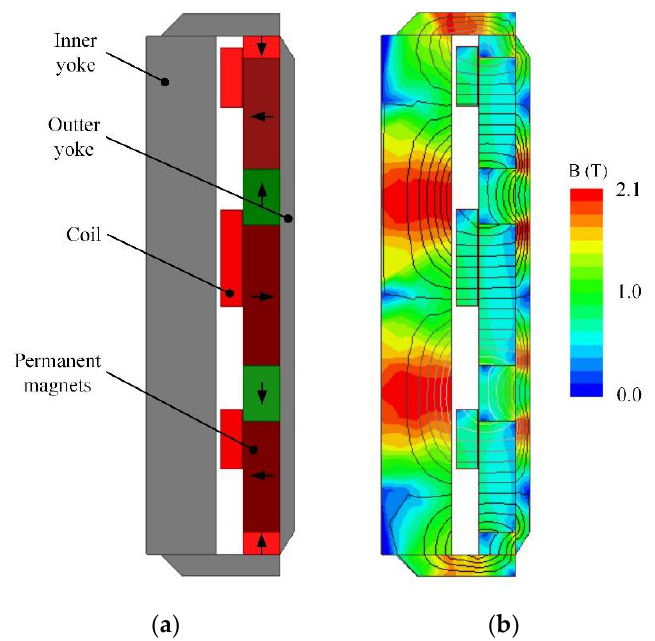
Figure 2. Magnetic field distribution of the EMLA: ( a ) Finite element model; ( b ) Magnetic field distribution. Table 1. Main structure dimensions of the EMLA.